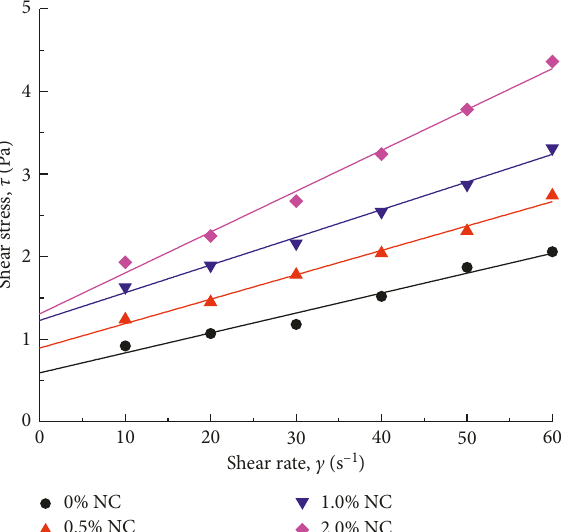
Figure 4: Typical flow curves of fresh grouts with different